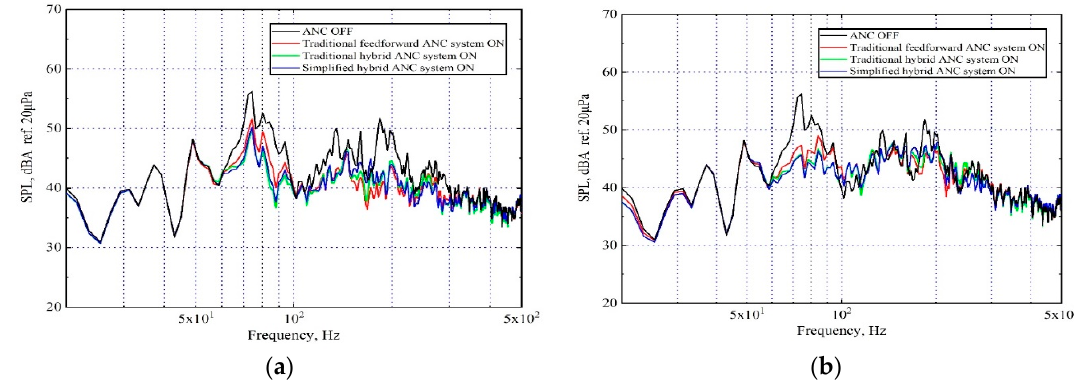
Figure 7. A-weighted averaged sound pressure level over two error microphones before and after control by applying different control systems, when the SUV was driven at a constant speed of 80 km/h on a rough road, ( a ) using ten vibrational reference signals; ( b ) using ten acoustical reference signals.